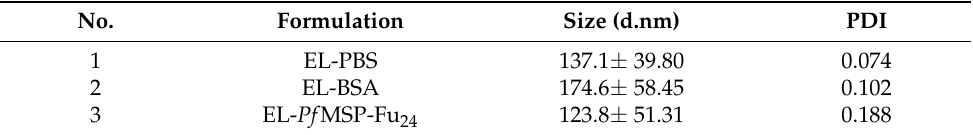
Table 5. Determination of size and polydispersity index (PDI) of elastic liposomes.